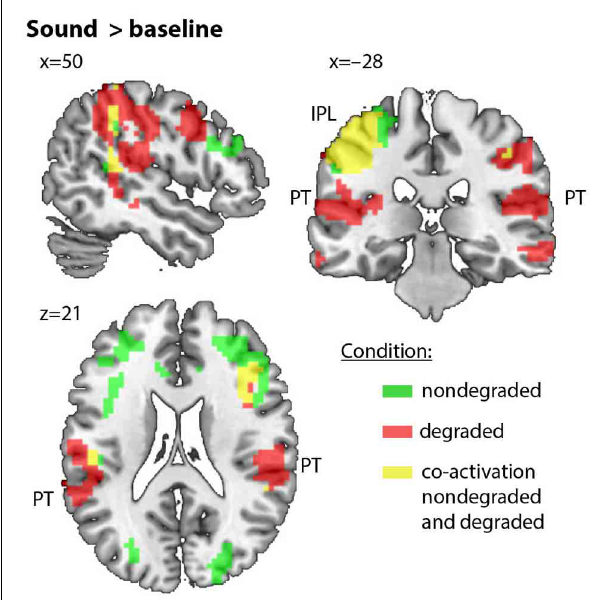
FIGURE 3 | Regions of the sounds > baseline contrast in nondegraded (green) and degraded (red) condition (co-activation in nondegraded and degraded condition: yellow). Slices focus on the temporo-parietal network. Note that overlap/co-activation is shown as illustrative means and is not based on statistical measures.